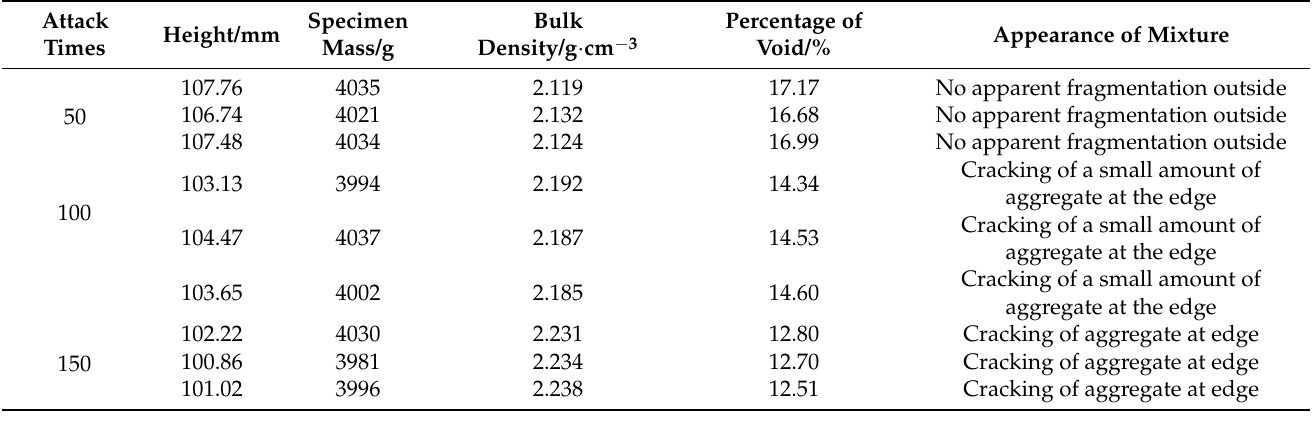
Table 5. OLSPM-25 volume parameters and mixture appearance under different compaction times.